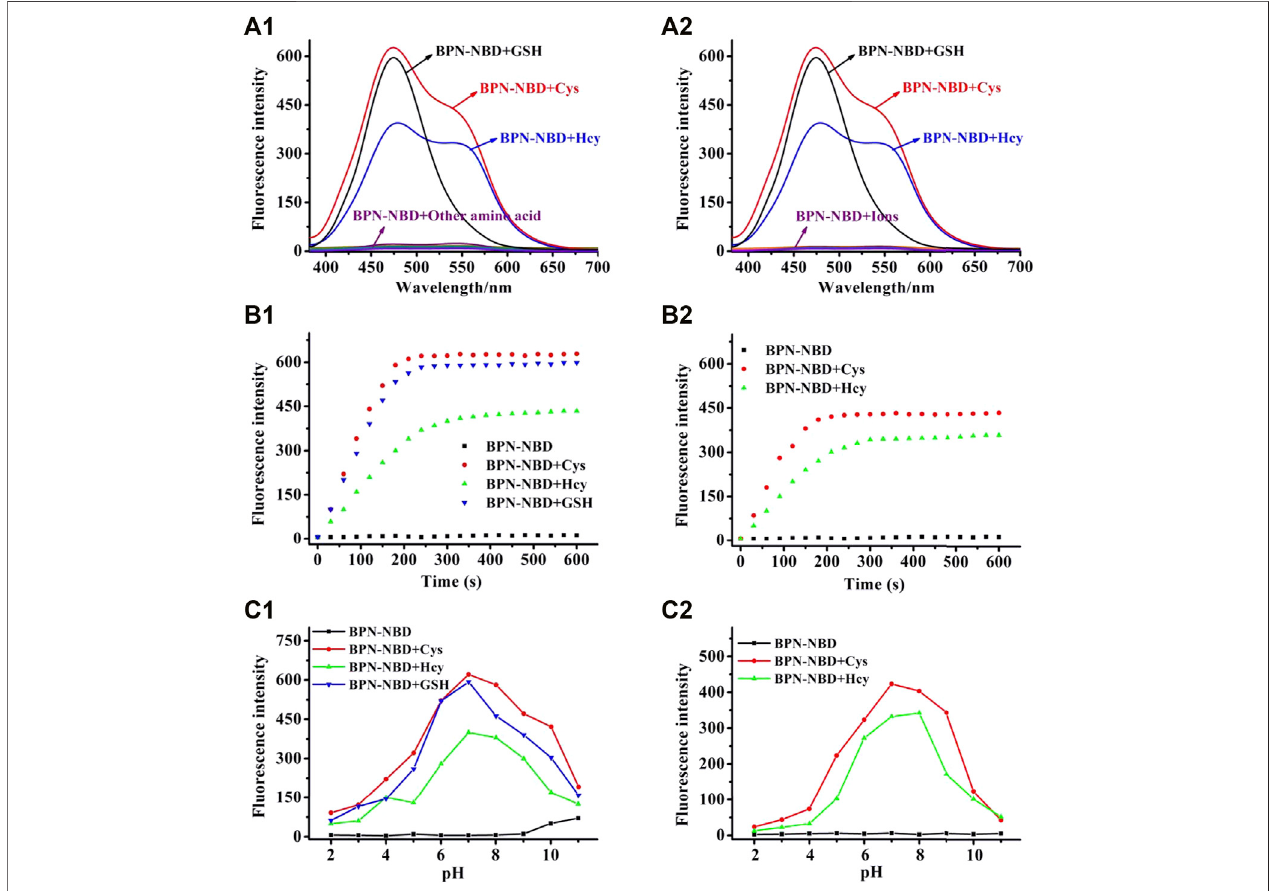
FIGURE 2 | (A1,A2) Fluorescence spectral changes of BPN-NBD (10.0 μ M) for (50.0 μ M) biothiols in pH 7.4 PBS buffer (Cys/Hcy and GSH) or other analytes (100.0 μ M for other amino acids, 500.0 μ M for ions). (B1,B2) Photostability of BPN-NBD (10.0 μ M) when reacted with Cys/Hcy or GSH (50.0 μ M) over time-dependent fl uorescenceintensitychangesat475and545 nminpH7.4PBSbuffer. (C1,C2) EffectofpH(2.0 – 11.0)onBPN-NBD(10.0 μ M)intheabsence/presenceofCys/Hcyor GSH (50.0 μ M) at 475 and 545 nm.